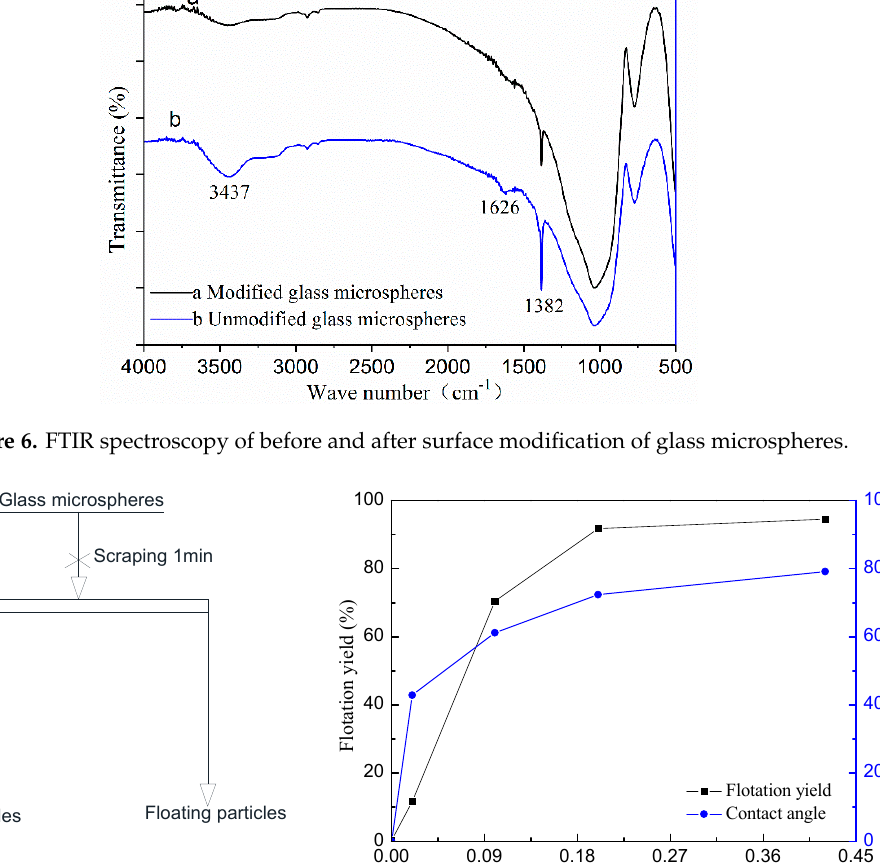
Figure 8. The contact angles of glass microspheres after modification (left: 0.2 μ L/g TMCS; right: different amounts of TMCS for different size fractions) . The relationship between the contact angle of modified glass microspheres and the amount of TMCS is shown in Figure 8 (right). For the unmodified glass microspheres, the contact angle is 0°, meaning that they are highly hydrophilic. When the amount of TMCS was 0.02 μ L/g, the contact angle of the − 250 + 125 μ m glass microspheres was 21.59°, and the contact angle was 67.33° when the amount of TMCS was 0.2 μ L/g; the contact angle increased with the amount of TMCS used during the surface modification step. The same trend was found also for the other two size fractions. Figure